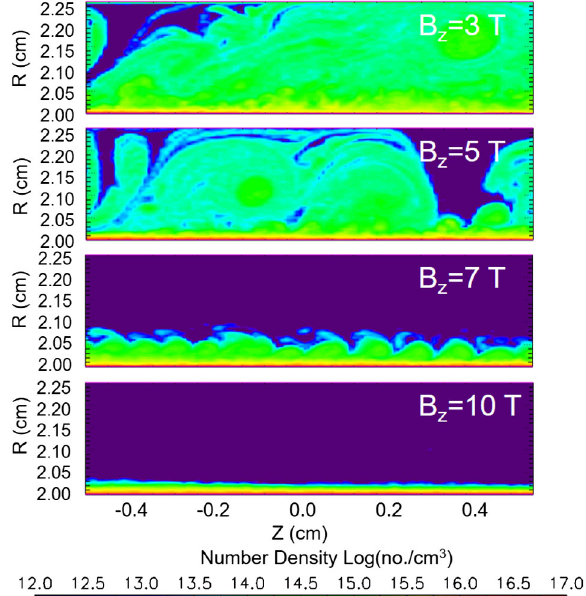
FIG. 5. A B z field is applied ranging from 3 to 10 T and the electron densities plotted after 10 ns. The injected current produces a peak B θ ¼ 6 . 5 T.